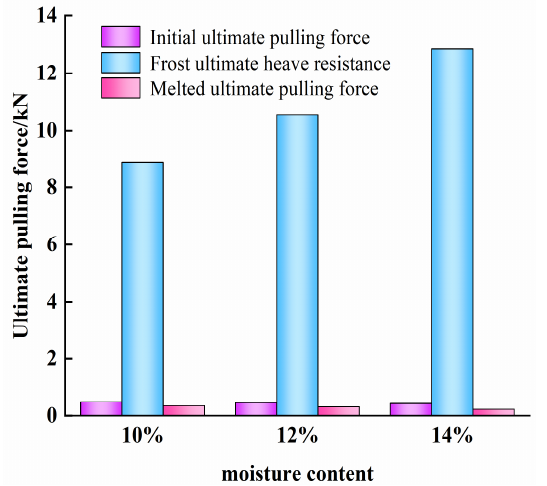
Figure 17. The relationship between the melting action and the ultimate pull-out force of bolts. Analysis of Figure 17 shows